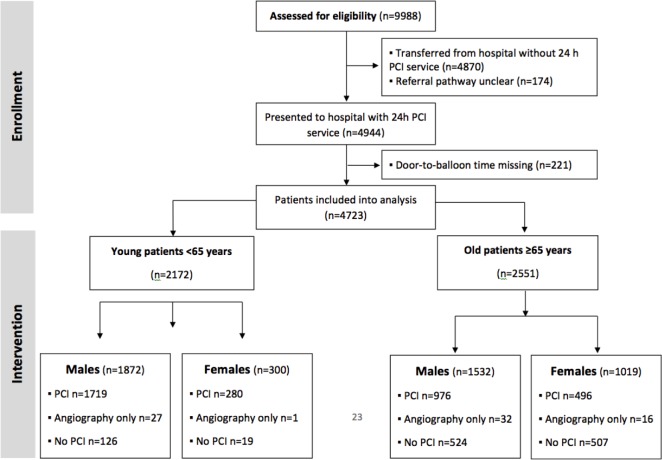
Flow diagram.Flow diagram of patients included into the analysis.